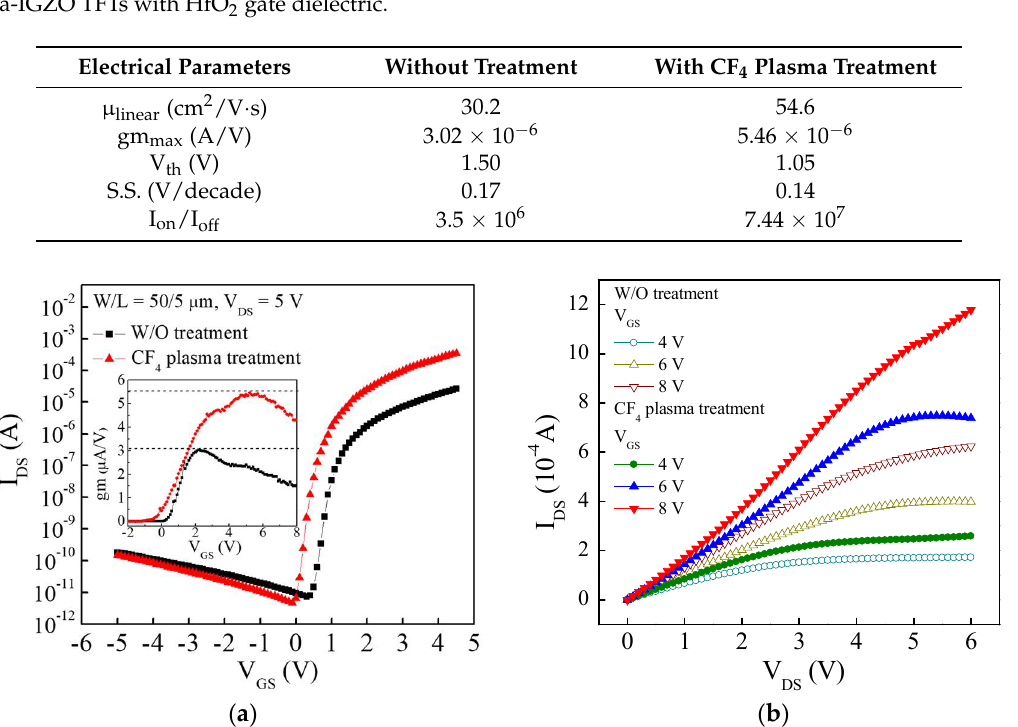
Figure 3. ( a ) Transfer curves (I DS -V GS ); ( b ) Output curves (I DS -V DS ) of the a-IGZO TFT without treatment and with a 15 W, 20 s CF 4 plasma treatment. Inset of Figure 3a shows the transconductance measured at V DS = 0.1 V.